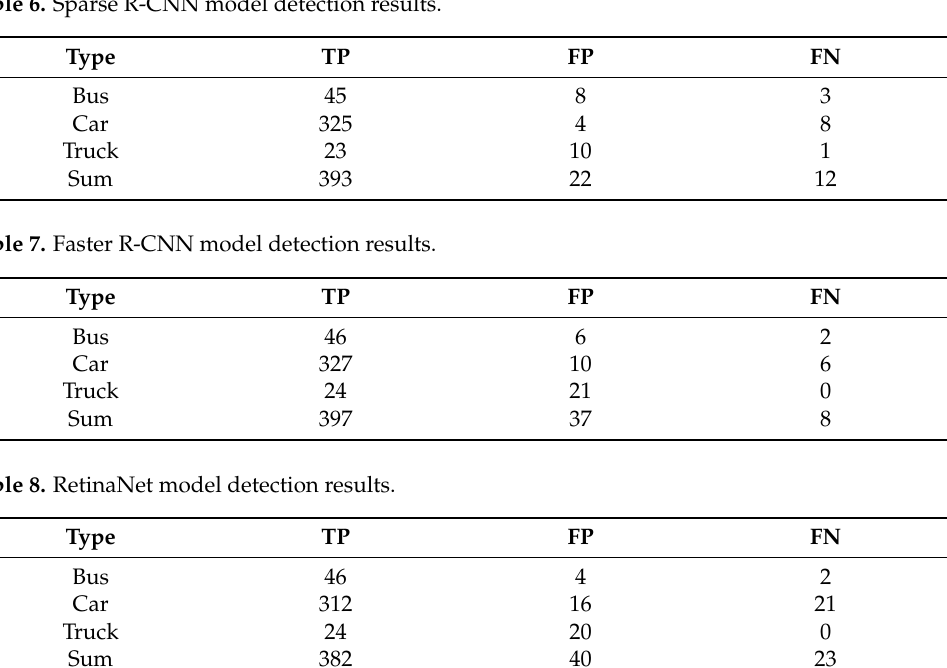
Table 6. Sparse R-CNN model detection results.